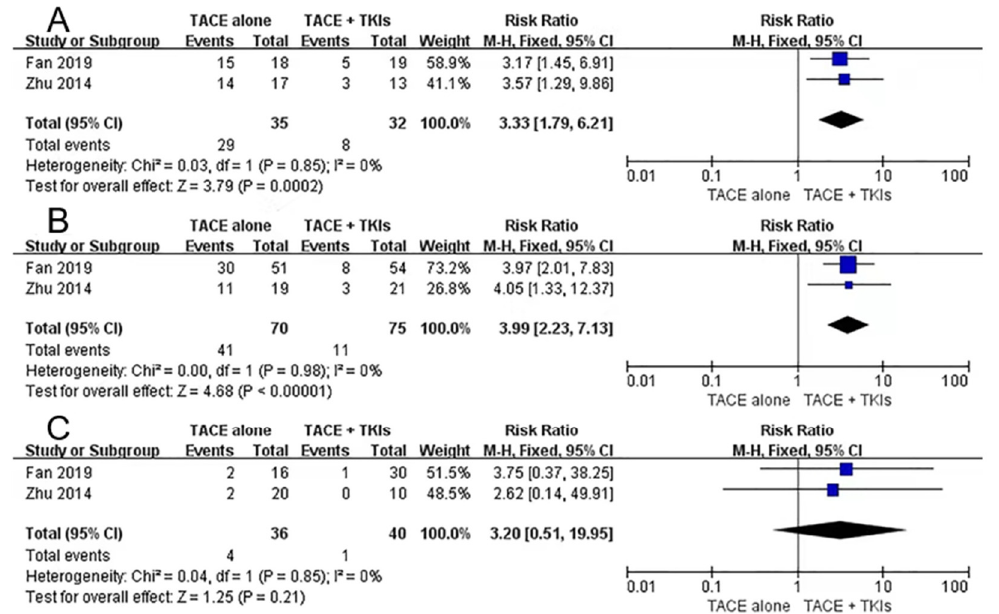
Figure 4. Subgroup analyses of disease control rate for combination therapy vs. monotherapy. ( A ): type I PVTT. ( B ): type II PVTT. ( C ): type III PVTT. TACE: transarterial chemoembolization; TKIs: tyrosine kinase inhibitors; PVTT: portal vein tumor thrombus